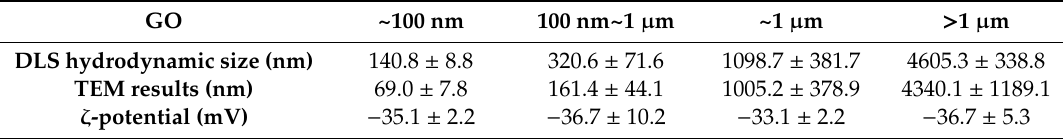
Figure 1. Preparation of GO from graphite and manufacturing of di ff erent GO sizes via probe sonication. Table 1. Nanomaterial size and ζ -potential of graphene oxide (GO) with di ff erent sizes in aqueous solution (transmission electron microscopy (TEM) images were calculated for 50 pieces of GO sheets for each